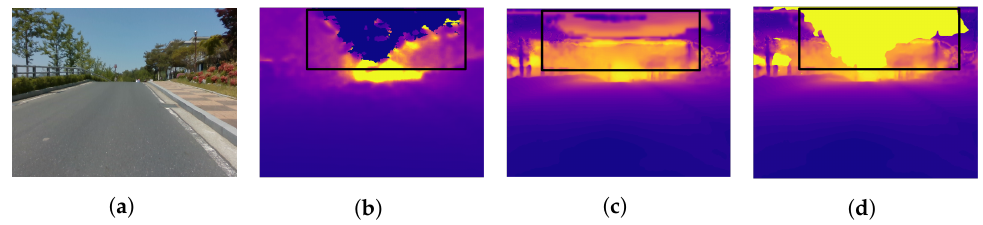
Figure 7. Sensing range extension result. ( a ) RGB, ( b ) stereo depth with sky in black box, ( c ) depth fusion without sky using semantic segmentation, and ( d ) depth fusion (Purple is near yet yellow is far distance).